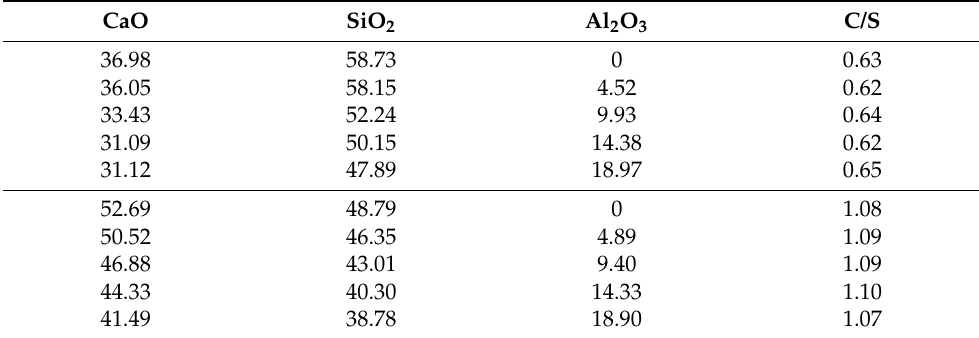
Table 1. Pre-melting slag components without B 2 O 3 , as determined from X-ray fluorescence and inductively coupled plasma analysis, wt%.